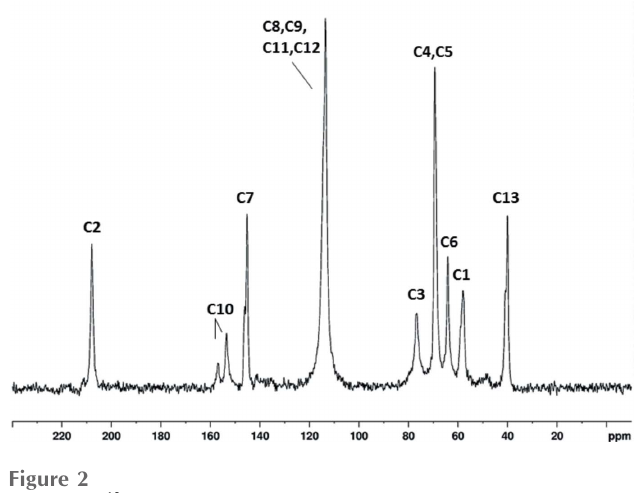
Figure 2 Solid-state 13 C NMR spectrum of powdered (I).